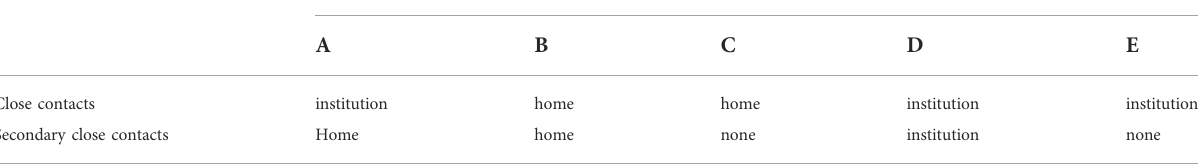
TABLE 1 Different types of quarantine policies. “ Home ” means home-based quarantine and “ institution ” means institution-based quarantine. Five types (A – E) of quarantine policies are studied. Contact pattern